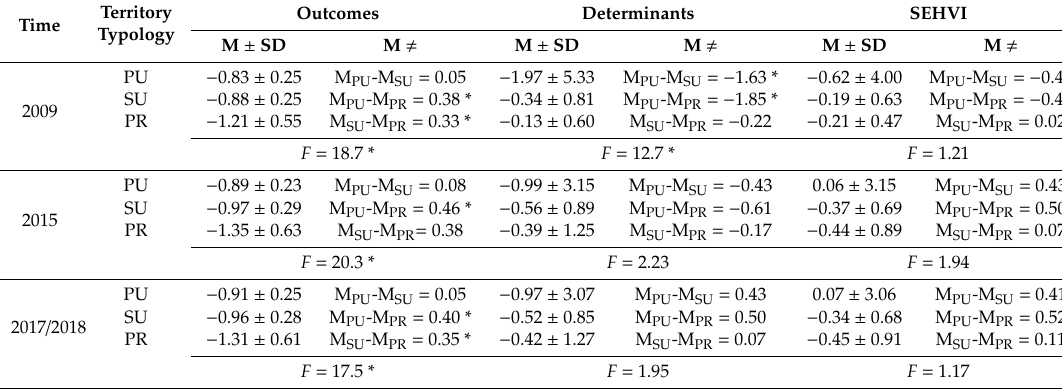
(cid:35) predominantly rural.